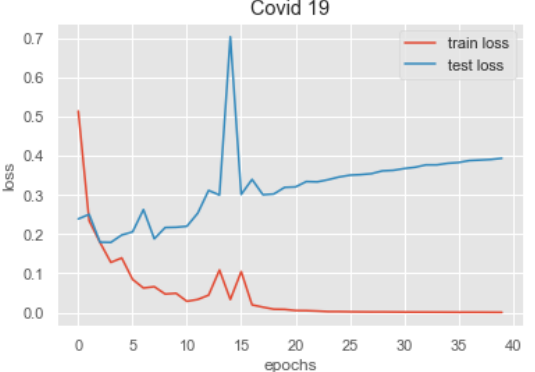
Figure 8 . Loss for the training and test data.